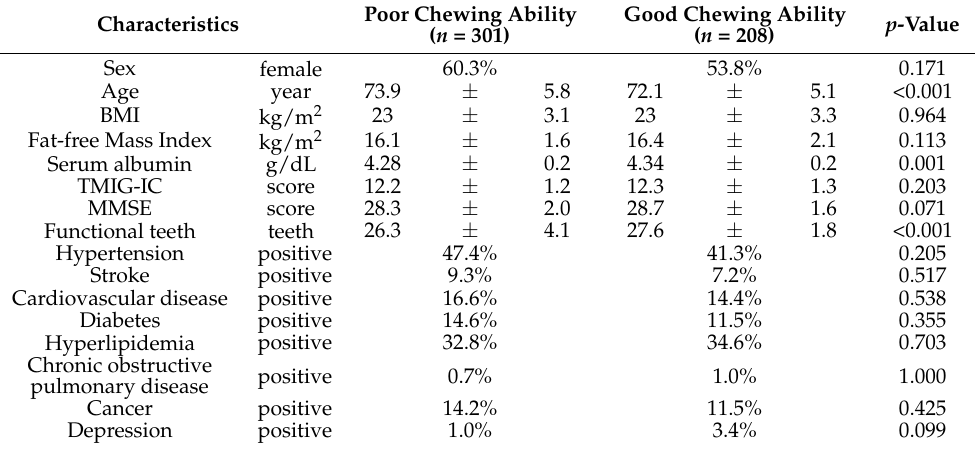
Table 1. Subject characteristics compared to chewing ability.